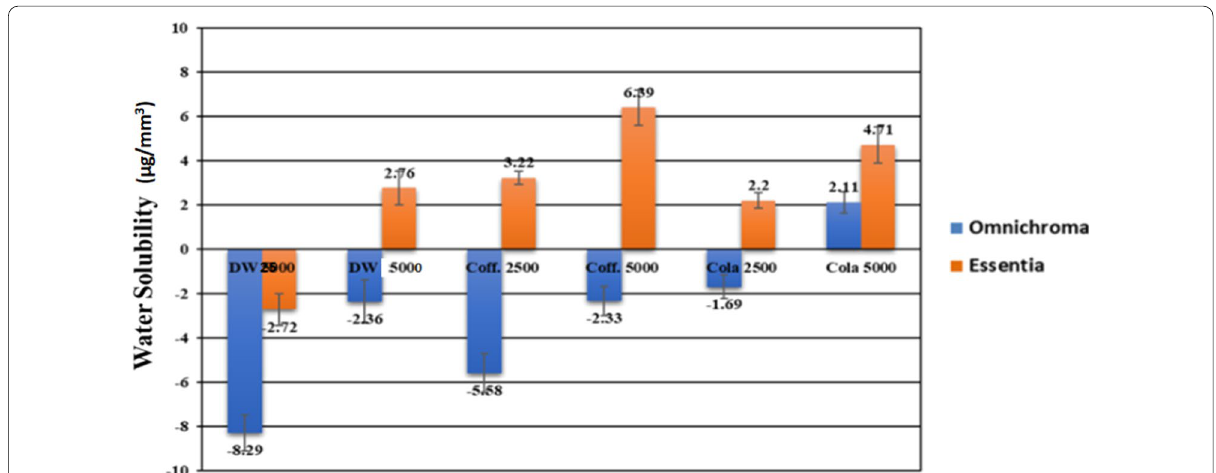
Fig. 3 The histogram showed water solubility values after TC 2500 and 5000 of Omnichroma and Essentia composite